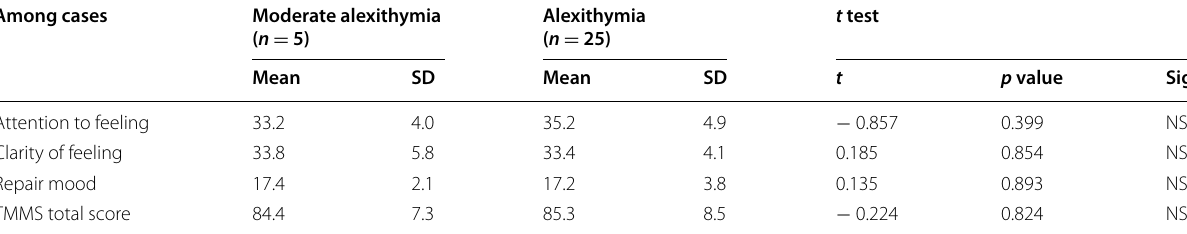
NS non-significant, S significant